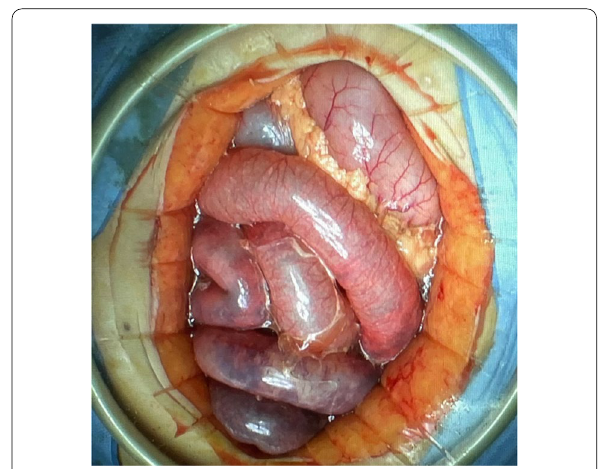
Fig. 1 Intraoperative image. Small intestinal and ascending colon necrosis with skip lesions was revealed in emergency laparotomy